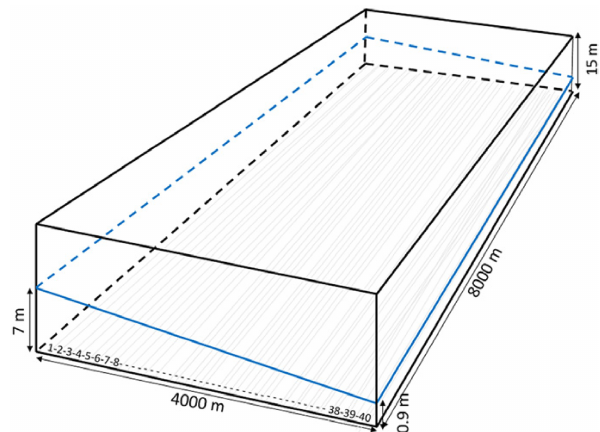
Figure 6. Model domain and initial water table position for the 2D flow model (Beegum et al., 2018).